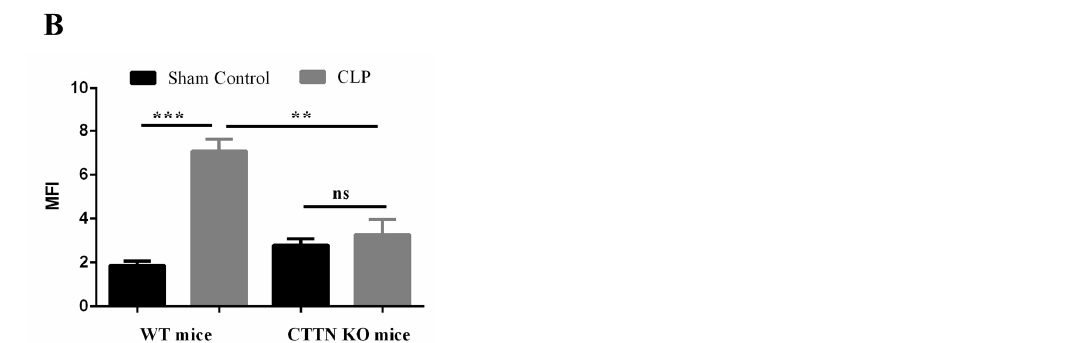
Figure 5. Sepsis-induced oxidative stress is reduced in the lungs of cortactin-deficient mice. ( A ) Rep- resentative images from freshly stained lung tissue cross-sections with dihydroethidium (DHE). Pictures were taken with a confocal laser scanning microscope; objective: 40×. Scale bars: 50 μ m. ( B ) Quantification of the mean fluorescence intensity (MFI) of oxidised ethidium fluorescence indicat- ing oxidative stress. Data are represented as means ± SEM of at least 4 animals per group. ** p < 0.01, *** p < 0.001, ns: not significant. DAPI, 4 ′ ,6-diamidino-2-phenylindole.